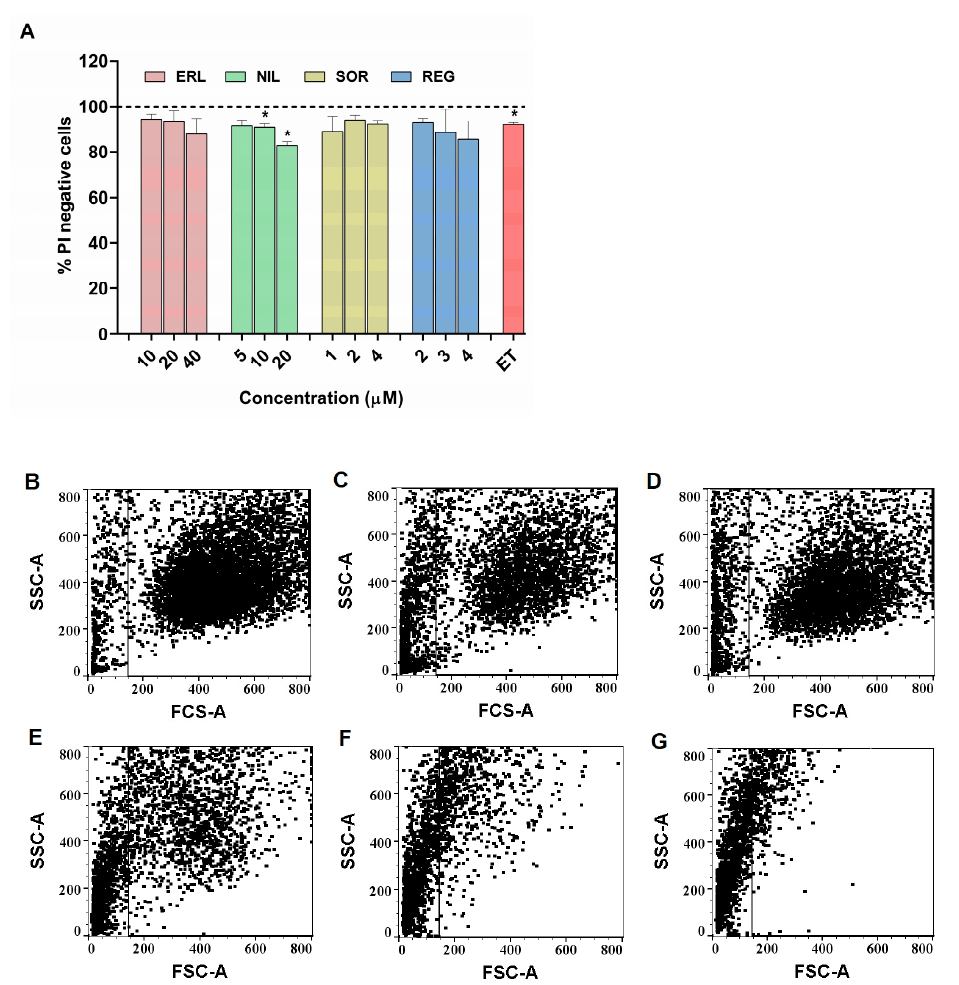
Figure 2. Effect of erlotinib (ERL), nilotinib (NIL), regorafenib (REG), and sorafenib (SOR) on zebrafish liver cell (ZFL) viability. ( A ) Viability of ZFL after 72 h exposure was determined using propidium iodide staining (PI) to distinguish between live and dead cells using flow cytometry. ET (0.17 µ M) was used as a positive control. ( B ) Forward side scatter and side scatter (FSC/SSC) dot plots representing the distribution of ZFL cells after exposure to ( B ) control medium, ( C ) 0.17 µ M etoposide, ( D ) 50 μ M benzo[a]pirene, ( E ) 0.015 μ M DAS, ( F ) 0.03 μ M DAS, ( G ) 0.06 μ M DAS. Three independent experiments were performed. * ( p < 0.05).